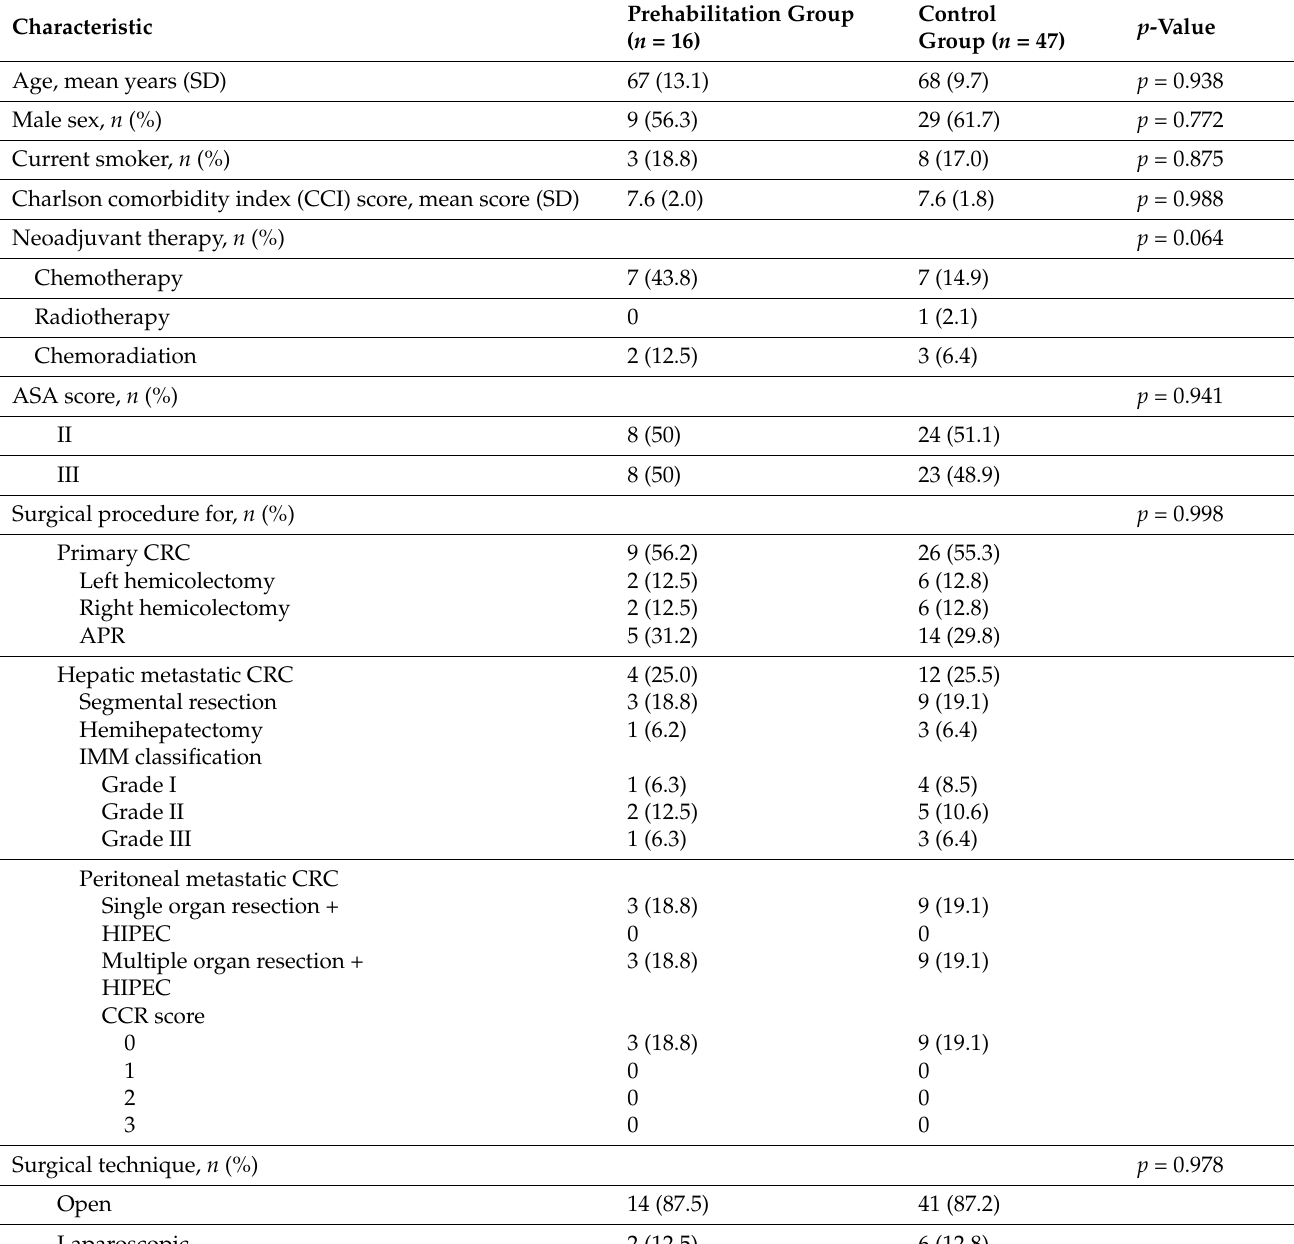
Table 1. Baseline